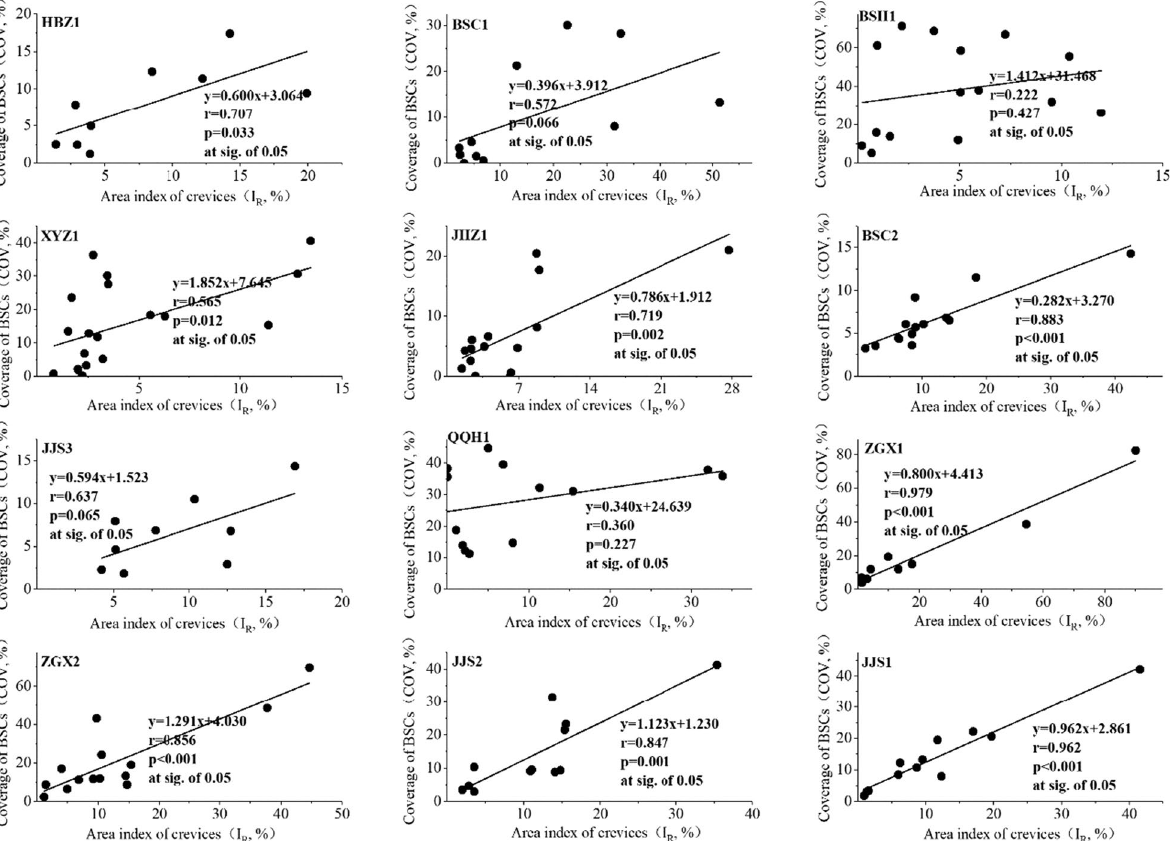
Fig. 4 Plots of BSC coverage and area index of crevices at 13 sampling